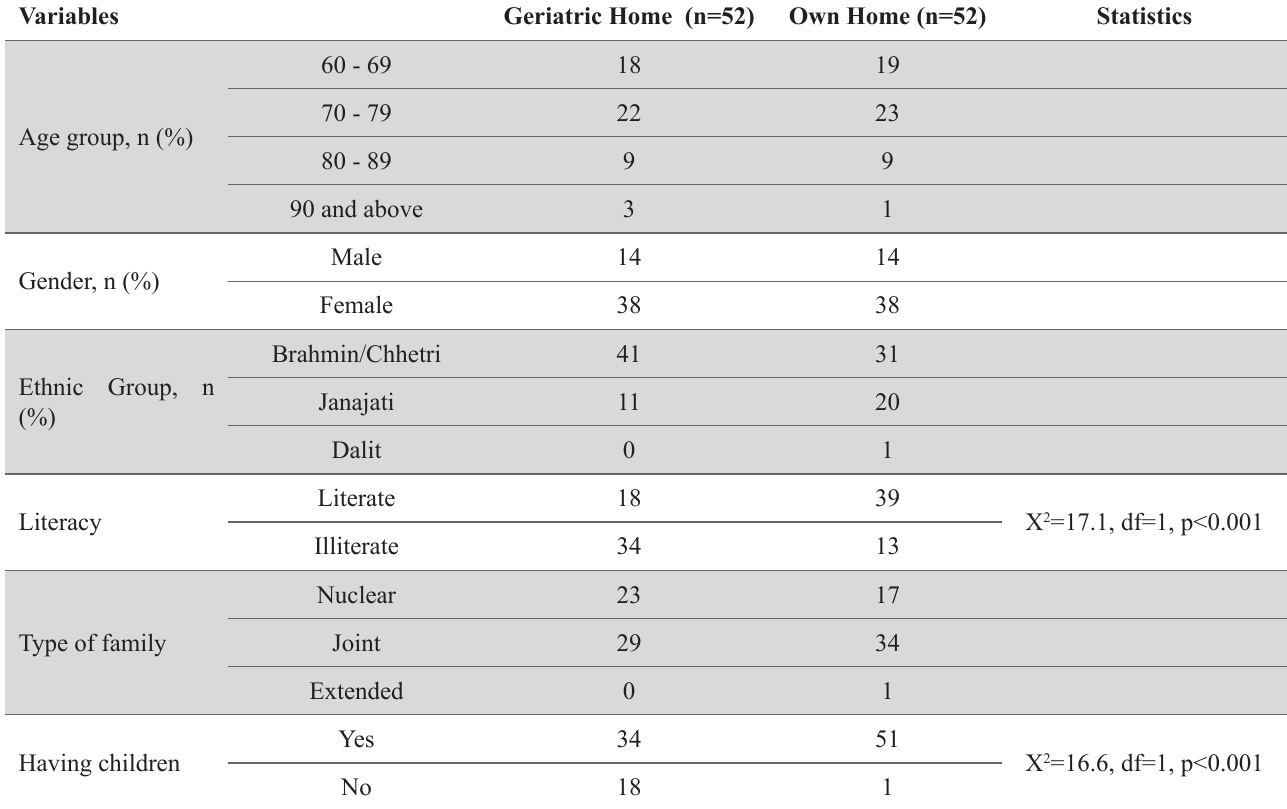
Table 1: Demographic details of the participants of geriatric home and own home